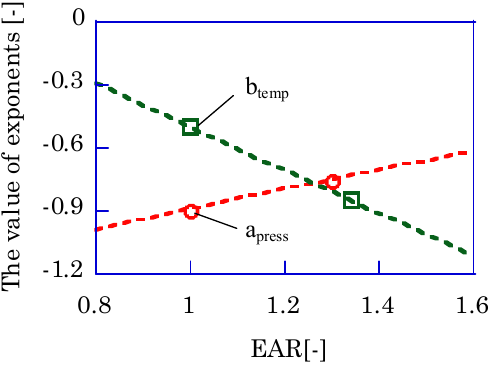
Figure 10. Excess air ratio effect on a press and b temp (Equation (2)) [21]. At the excess air ratio = 1.0 (the LHV of the mixture is large), the absolute of a press is larger than b temp . This means that the maximum pressure change is more effective because the temperature difference between the wall and the gas is large. On the other hand, at the excess air ratio = 1.3 (the LHV of the mixture is small), the absolute of b temp is larger than that of a press . At this excess air ratio, the gas temperature is very low. Then, the temperature change affects the quenching distance. This temperature effect related to the reactive gas component should be considered because these reactions are affected by temperature much.